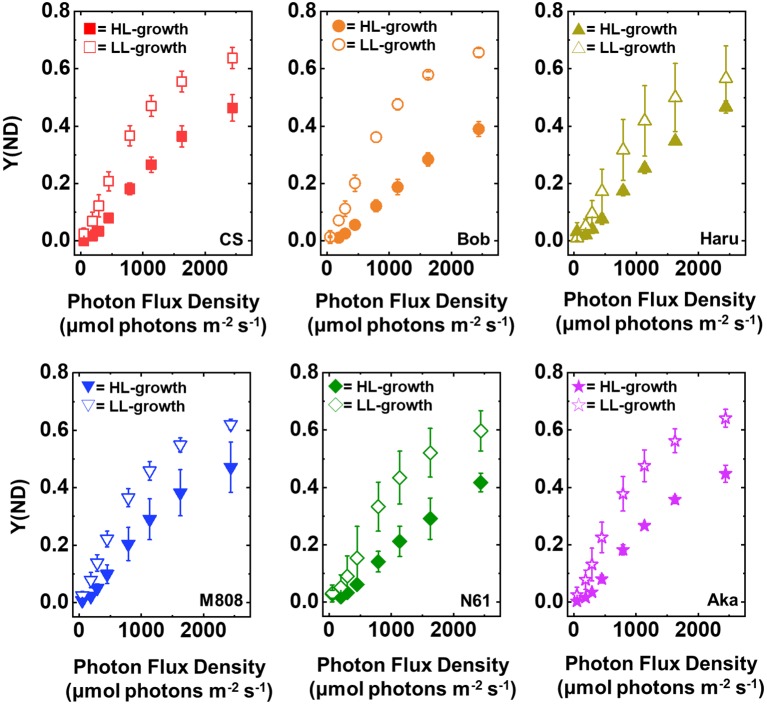
The response of Y(ND) to light intensity in six wheat cultivars grown under LL (open symbol) and HL (closed symbol) conditions. The measurement was conducted under atmospheric conditions (21 kPa O2, 40 Pa CO2) at 25°C. Data were expressed as mean ± SD of three to five independent experiments. Red squares indicate the results of CS, orange circles indicate the results of Bob, dark yellow triangles indicate the results of Haru, blue inverted-triangles indicate the results of M808, green diamonds indicate the results of N61, and purple stars indicate the results of Aka.